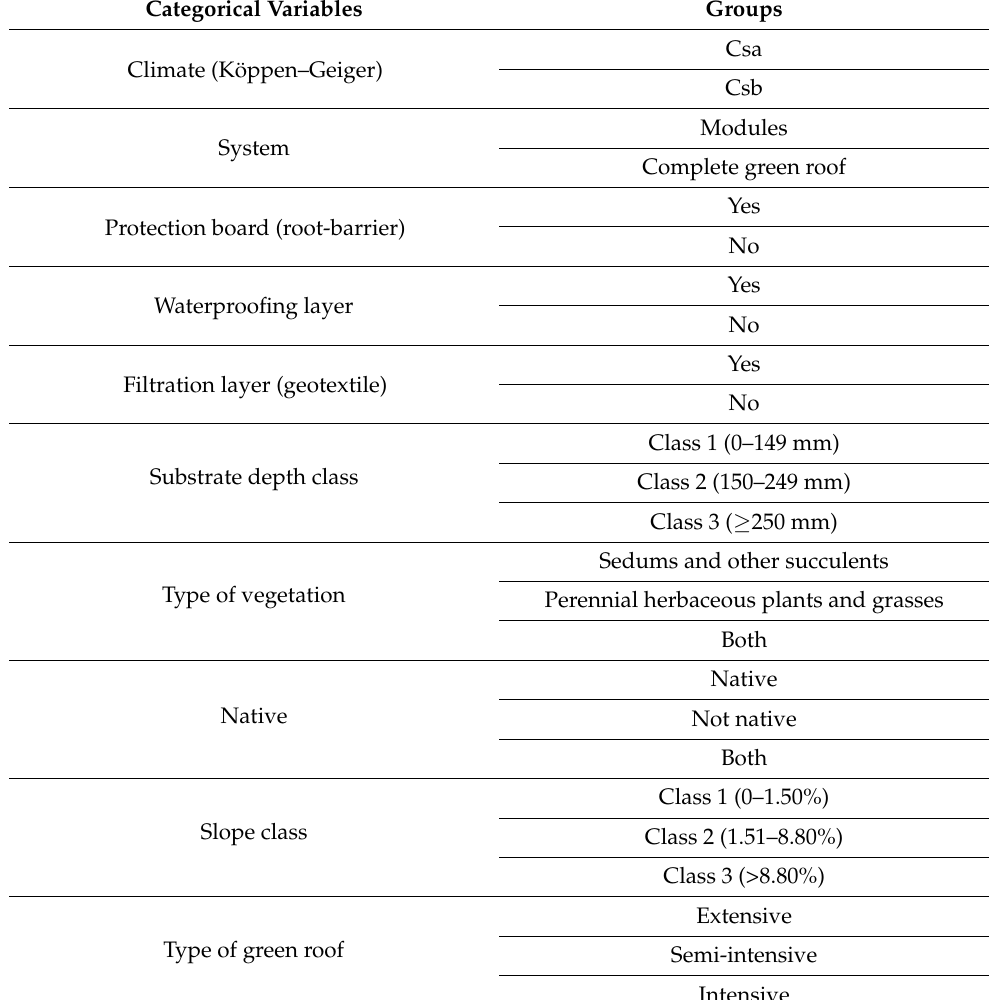
Table 2. Categorical variables under study and corresponding groups.